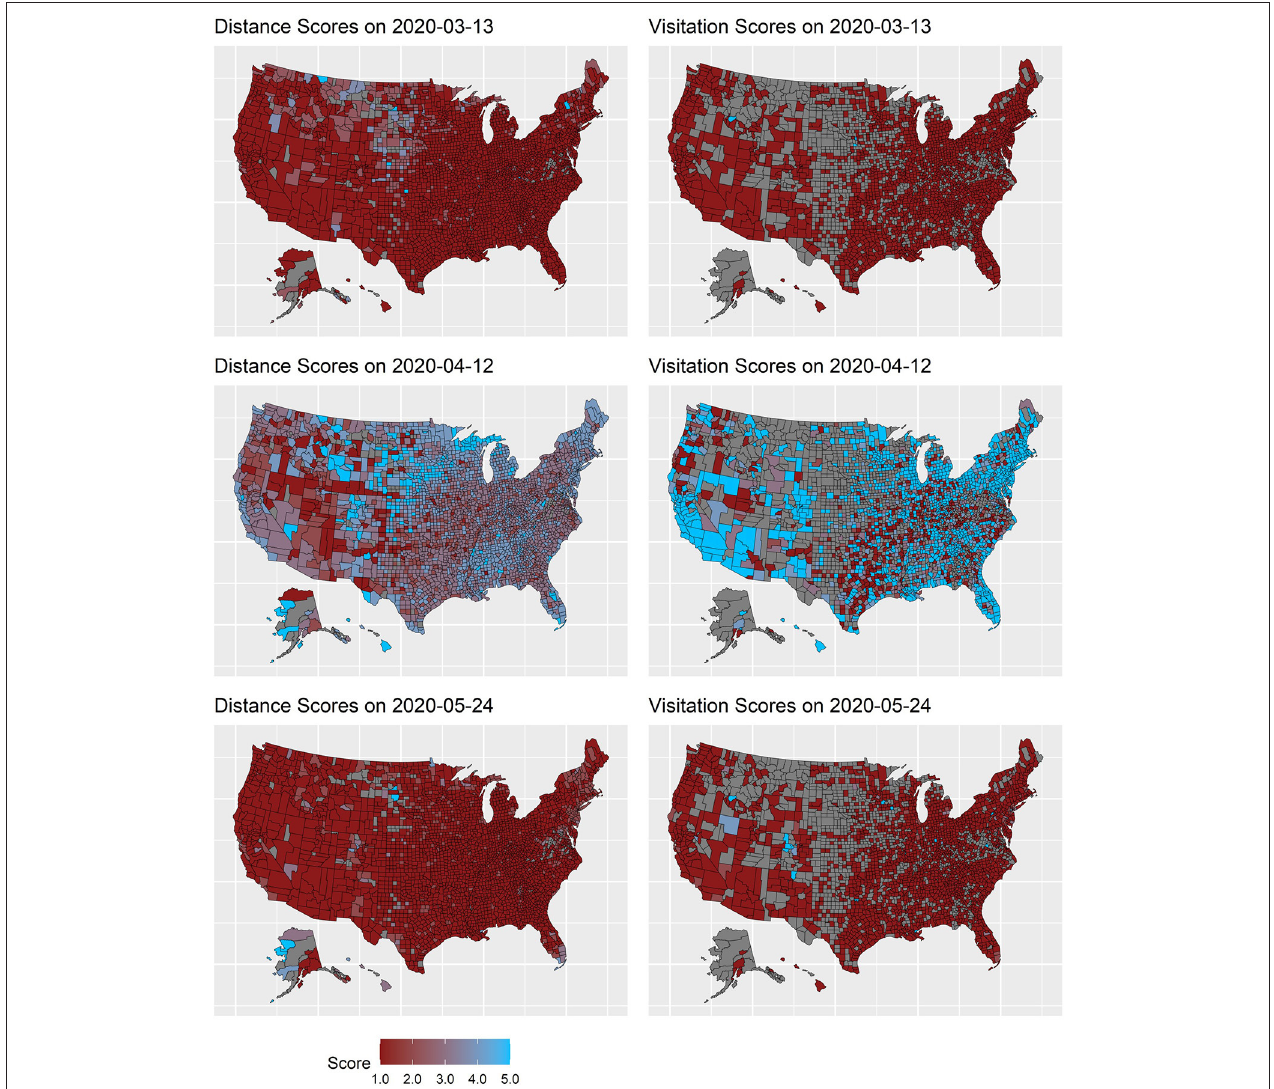
FIGURE 1 | Distance and visitation scores across three timepoints. Numeric Grade scores from Unacast Inc. are shown for ease of visual interpretation. Scores correspond to the following: 1 = F, 2 = D, 3 = C, 4 = B, and A = 5. Higher scores indicate greater social distancing. Distance scores were determined based on proportional reduction: A ≥ 70%, B = 55–70%, C = 40–55%, D = 25–40%, and F ≤ 25%. Visitation scores were based on: A ≥ 70%, B = 65–70%, C = 60–65%, D = 55–60%, and F ≤